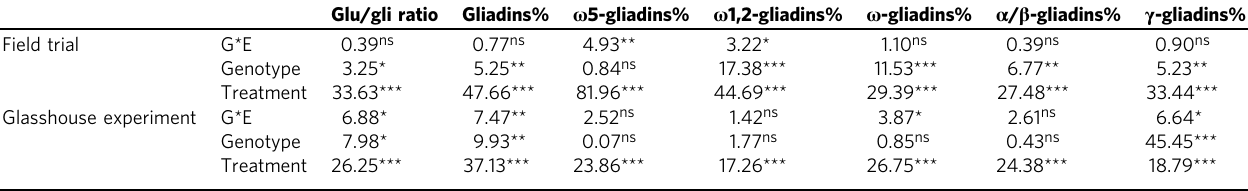
Table 3 Univariate analysis of variance of the impact of the genotypes (G), sulfur treatments (E) and G×E on gluten components in 2014 fi eld trial and glasshouse